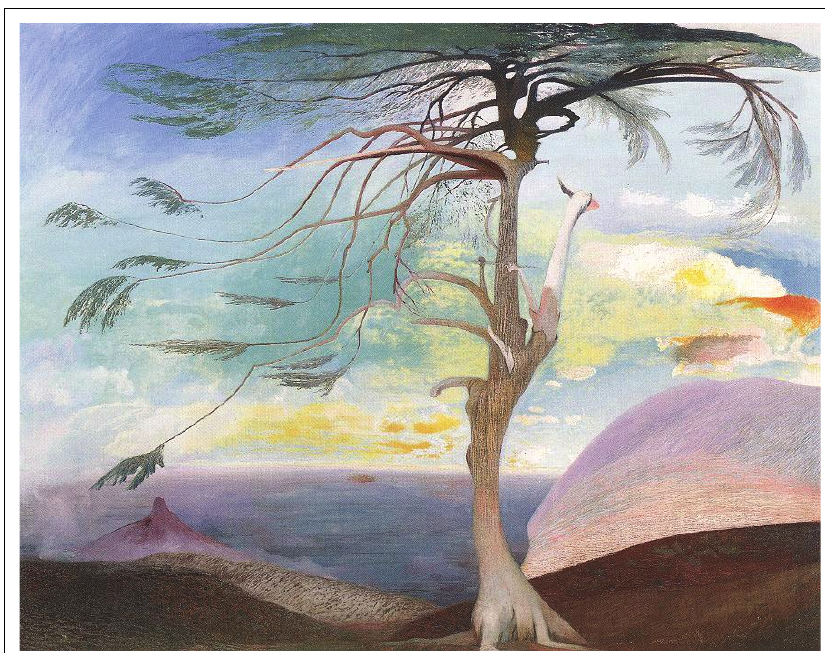
FIGURE 1 | Csontváry: The Solitary Cedar (Csontváry Museum, Pécs,